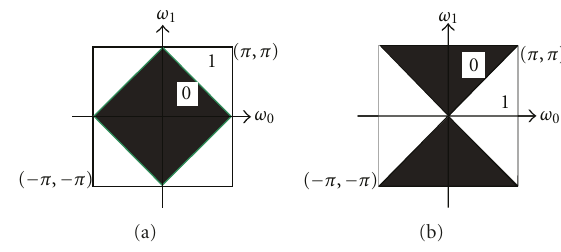
Figure 4: Diamond and fan filter of (a) and (b).